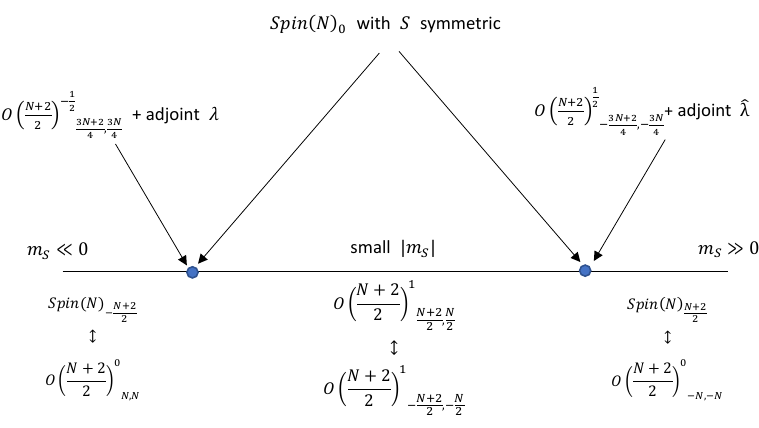
Figure 4: The phase diagram of a Spin ( N ) gauge theory coupled to a fermion S in the two-index symmetric tensor representation. It can be obtained from SO ( N ) gauge theory by gauging the magnetic symmetry in the UV, which corresponds to gauging the diagonal CM in the long-distance TQFT. The blue dots indicate the transitions from the semiclassical phase to the quantum phase. Each of these transitions can be described by a dual theory with adjoint fermions, in which the transition can be seen at weak coupling. These dual theories cover part of the phase diagram. These figures are identical to those in [ 15 ]